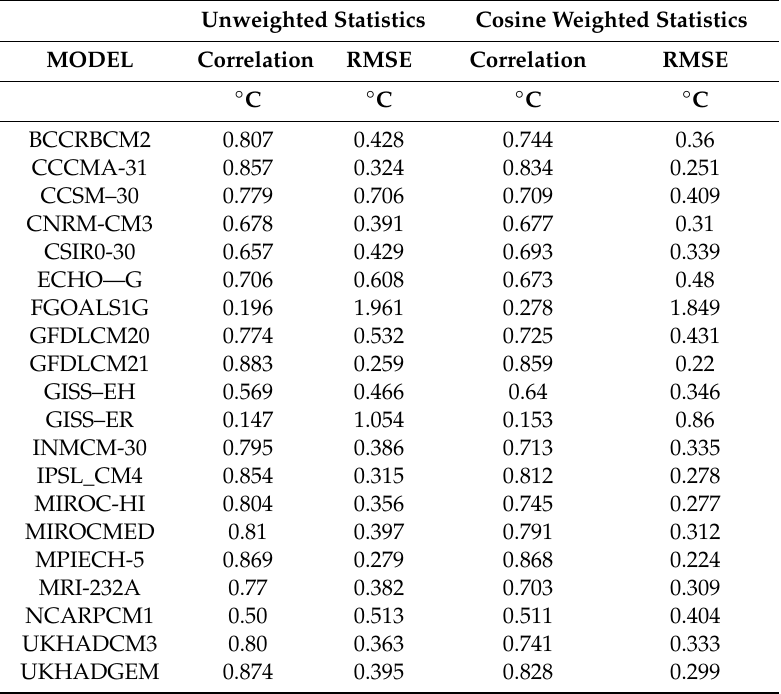
Table 1. Correlation between the models. Unweighted